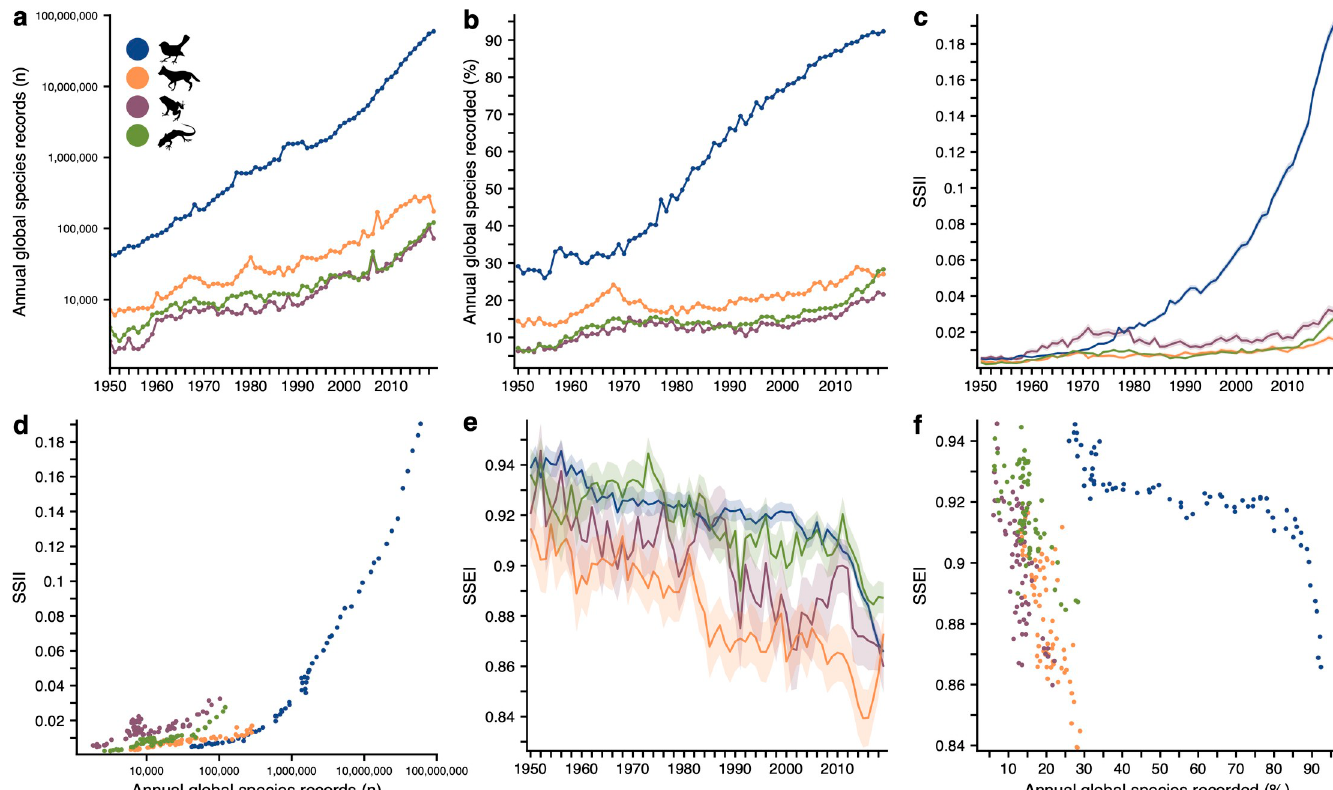
Fig 3. Global trends data coverage and sampling effectiveness across 4 terrestrial vertebrate groups. (a–c) Trends in total annual record counts ( a ),percentage of expected species recorded ( b ),and the Global SSII ( c ).Global SSII is based on data coverage across species’ ranges without consideration of national boundaries. Alternatively, Global SSII for a species is the sum of Steward’s SSII across the nations where it is expected to occur. ( d) Relationship between annual total record counts and Global SSII. ( e) Trends in Global SSEI. ( f) Relationship between percentage of expected species recorded and Global SSEI. ( c , e) Lines and shading represent means and 95% confidence intervals across species within classes. ( d , f) Relationships are shown over the past 70 years (1950–2019). Colors in a–f indicate birds (blue), mammals (orange), amphibians (purple), and reptiles (green). Artwork from phylopics . org(see Text A in S1 File). The data underlying this figure may be found in https://mol.org/ indicators/coverage and https : //github . com/MapofLife/biodiversity-data-gaps .SSEI, Species Sampling Effectiveness Index; SSII, Species Status Information Index.